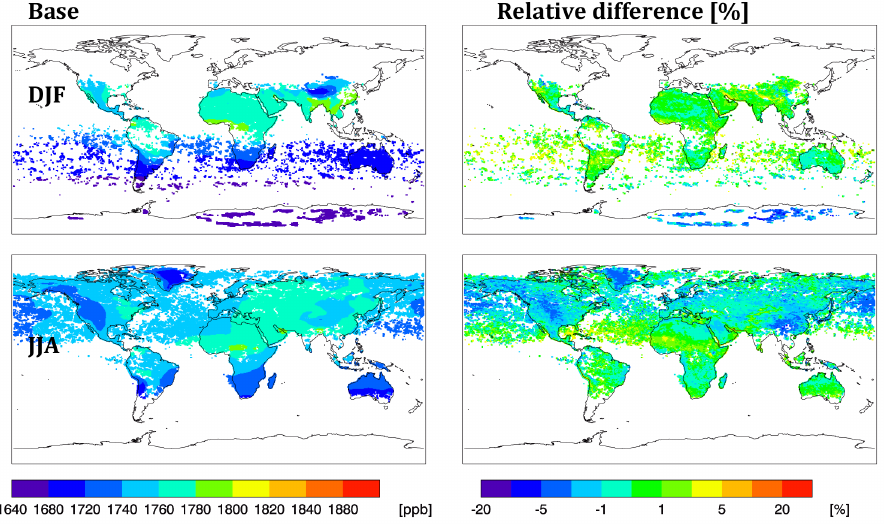
Figure 8. Seasonal mean (2004) methane dry column (ppbv; left column) from the Base scenario and the relative difference (%, ( Base observations) / observations; right column) with SCIAMACHY data. Simulated methane levels are gridded to the spatial resolution of the SCIAMACHY